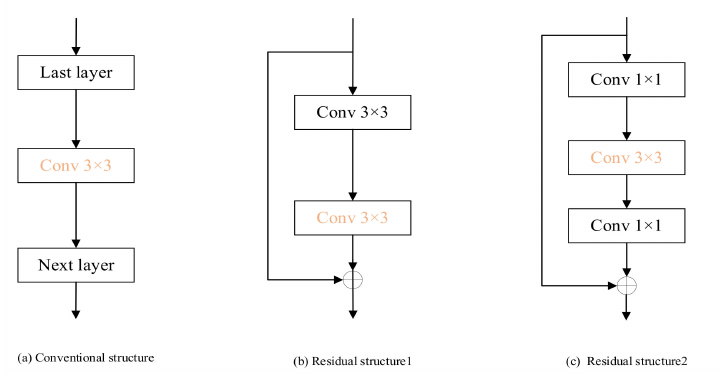
Figure 4. Different network pruning